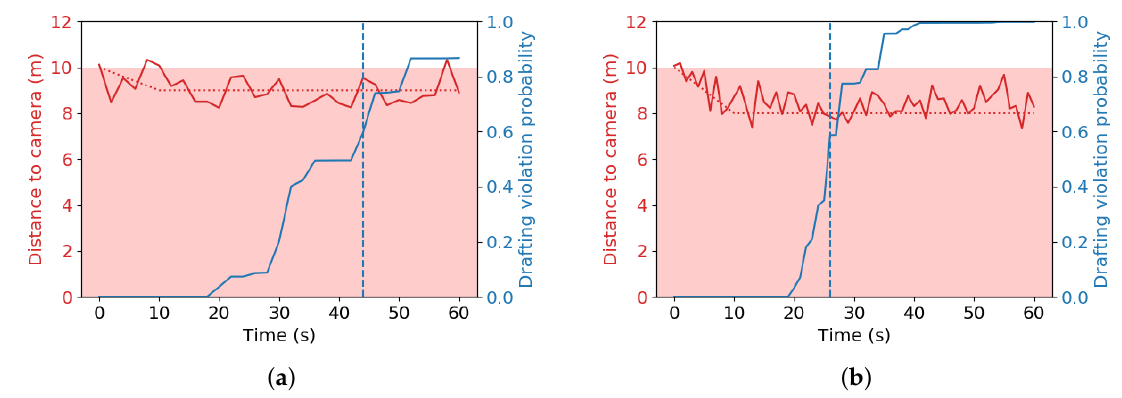
Figure 16. Example simulations of drafting violation probability over a given time frame. The cyclist enters the drafting zone in the beginning, and then settles at a new distance after 10 s (red dashed line). Gaussian noise is independently added to all parameters to simulate an estimated distance (red solid line). The draft zone is colored pink. The evolution of the drafting violation probability is superimposed on the same graphs (blue solid line). A blue dashed vertical line indicates when P ( v 1: n | x 1: n ) > 0.5 for the first time. ( a ) Cyclist riding at 9 m, sampling period 2 s, small systematic errors; ( b ) cyclist riding at